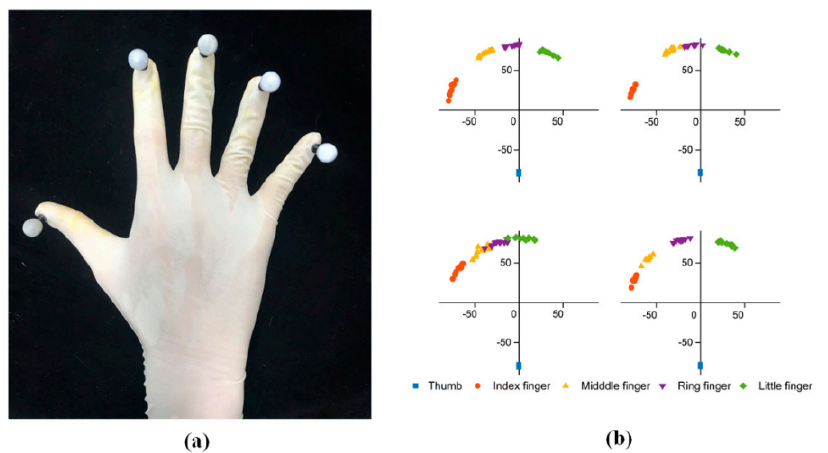
Figure 11. ( a ) A glove with markers can be captured by a motion tracking system; ( b ) contact point distribution of grasping a 120 mm diameter disk under four conditions. The unit of coordinate system is